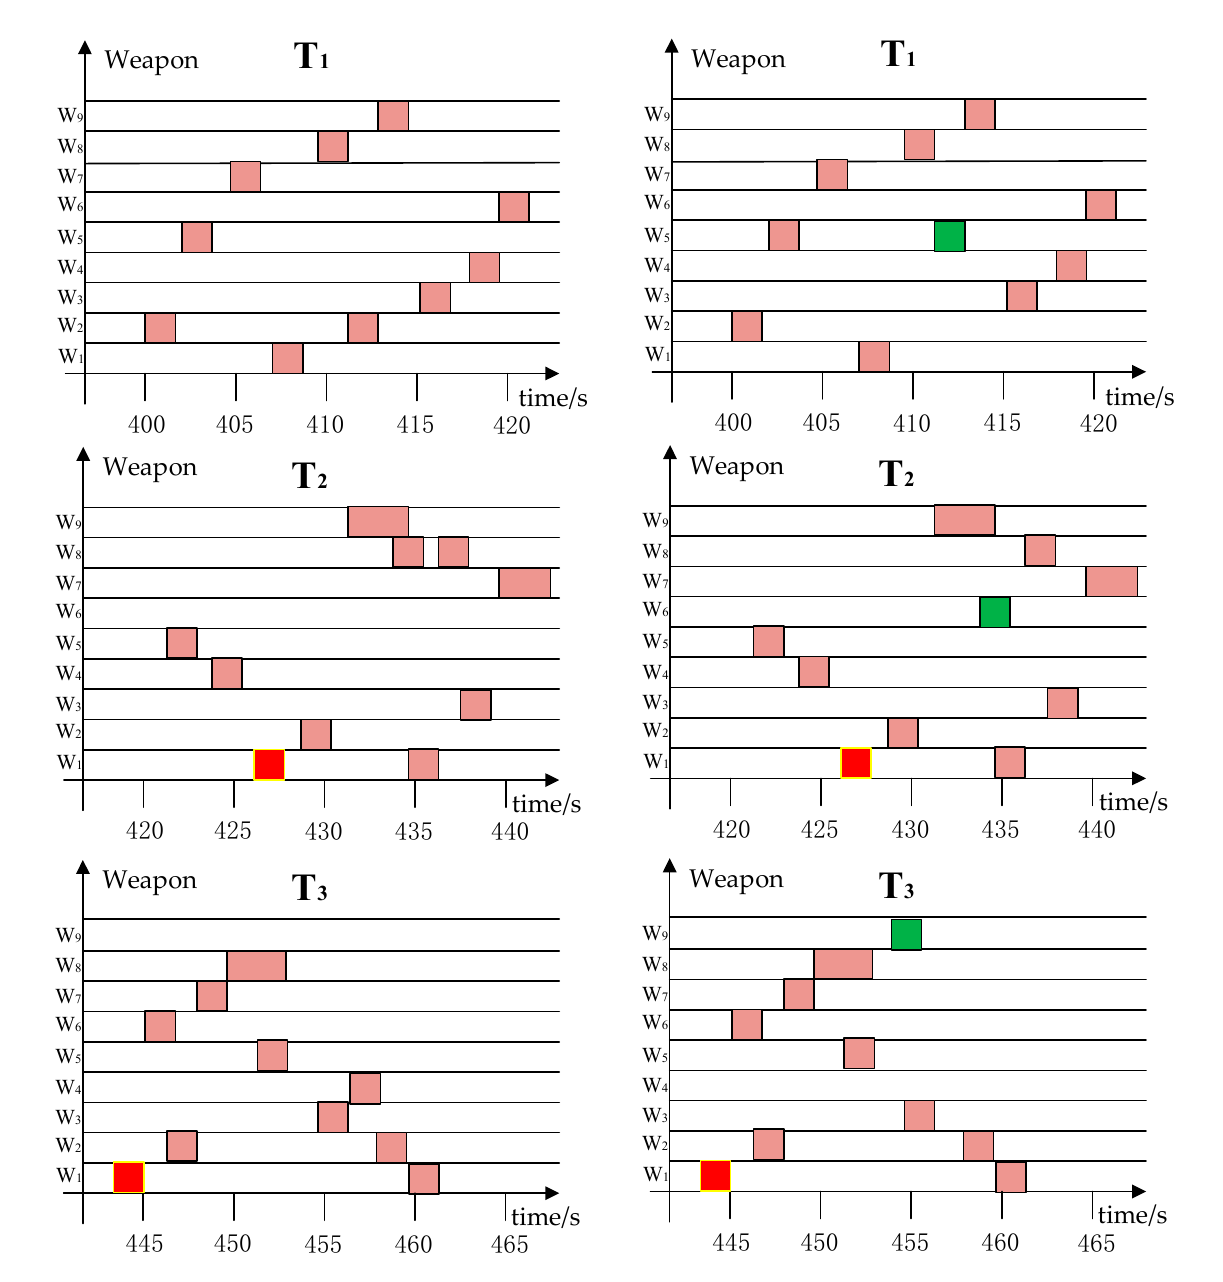
Figure 17. Weapon target allocation scheme.